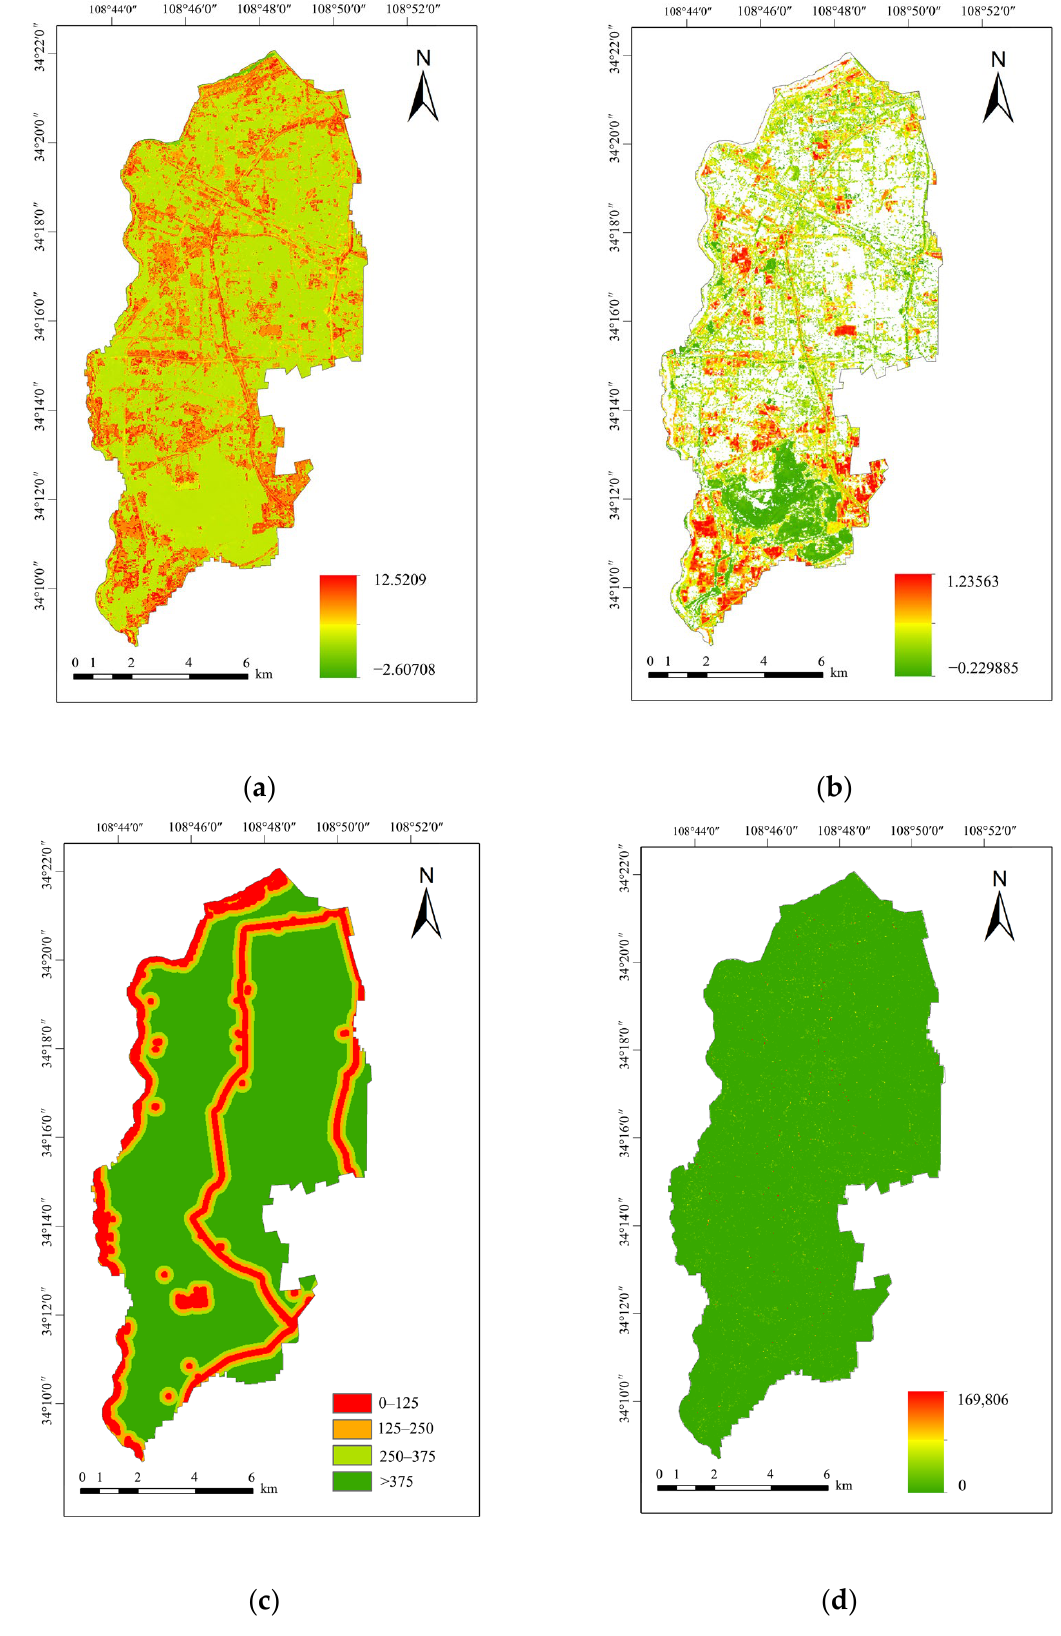
Figure 4. ( a ) Biodiversity conservation capacity; ( b ) fractional vegetation cover; ( c ) distance from the water source; ( d ) calculation results of Chinese Soil Loss Equation.